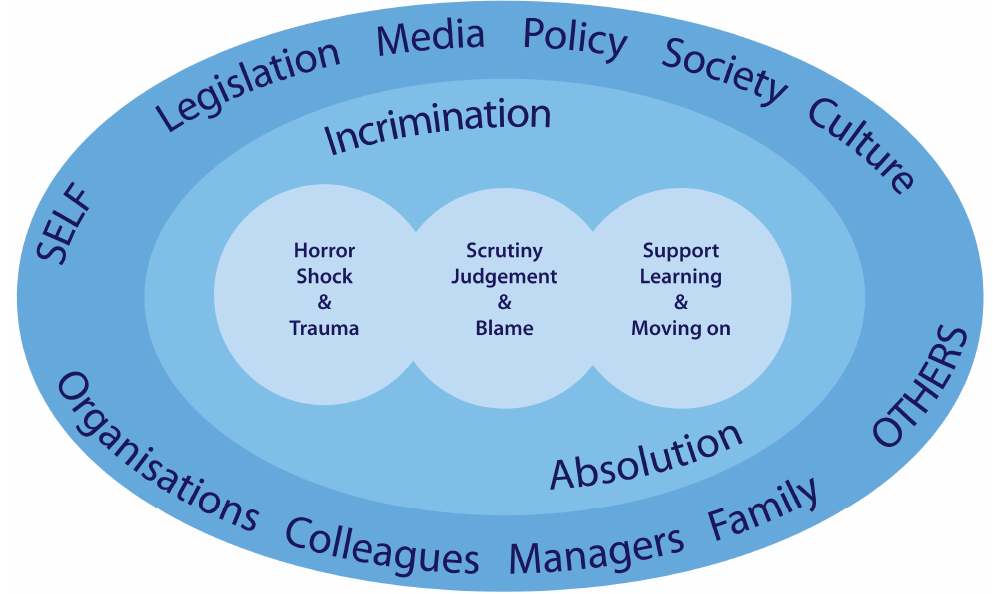
Figure 2. An overarching framework of the context surrounding practitioner experiences.